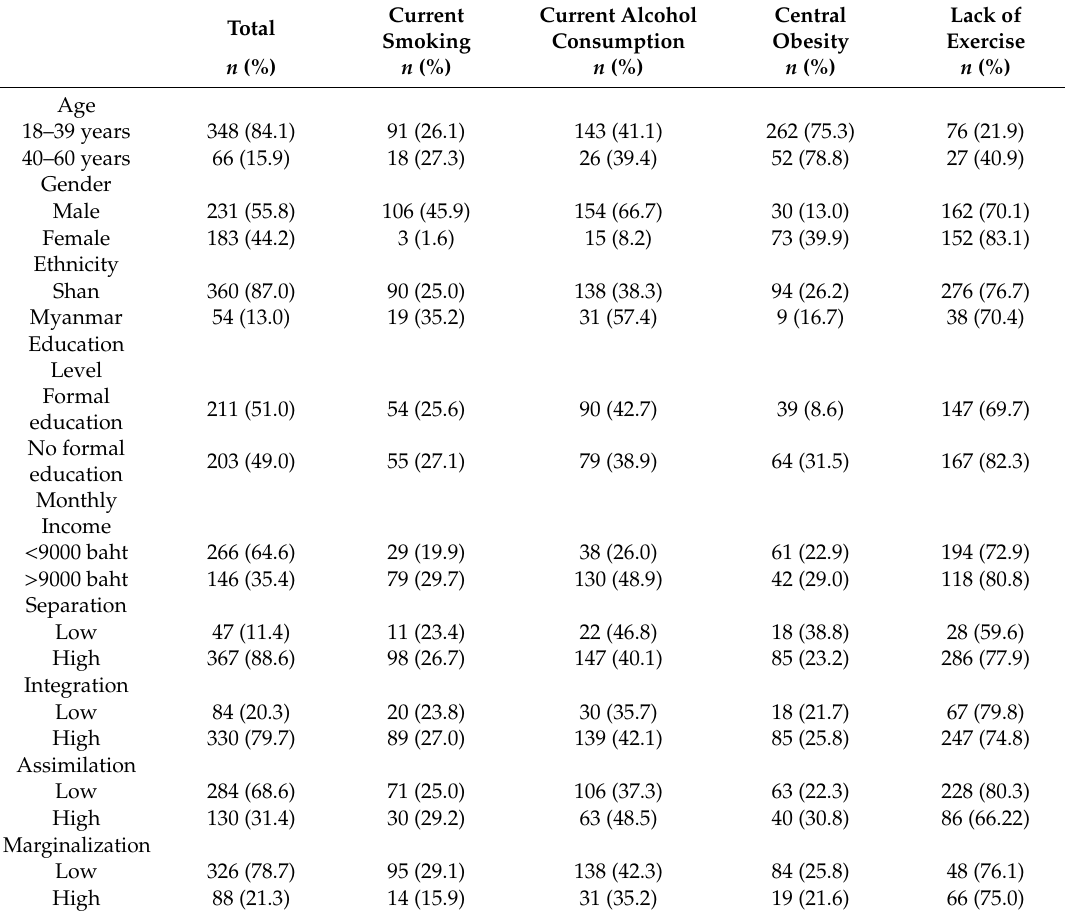
Table 1. Characteristics of the study